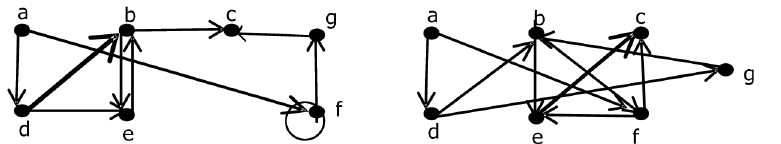
Fig 5. Sample graphs of anonymized network of Fig